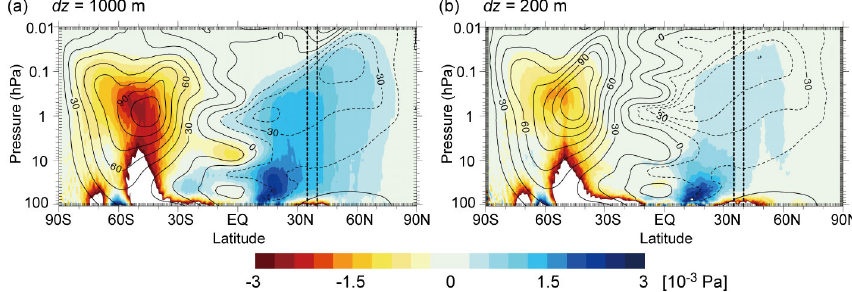
Figure 5. The zonal mean eastward winds (contours) and net upward flux of the eastward momentum associated with the gravity wave component ( λ h < 950km) in the d z = 1000m (a) and d z = 200m (b) simulations. Averages from 00:00UT, 23 June, to 00:00UT, 27 June, are shown. The color shading with momentum flux larger than ± 3 × 10 − 3 Pa are omitted. The latitude box of 35–40 ◦ N is indicated, which we mainly focus on in the present